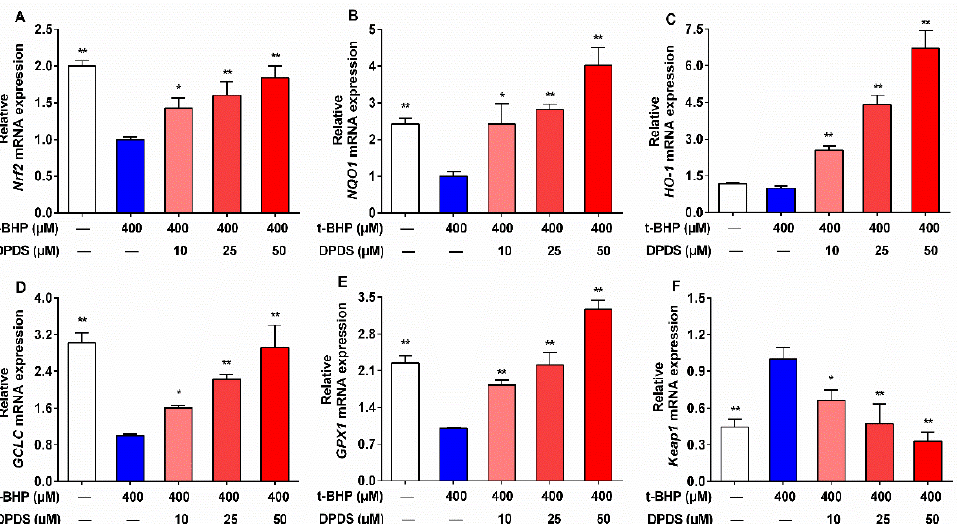
Figure 4. DPDS enhanced the gene expression of Nrf2 and antioxidant enzymes in t-BHP-stimulated HBZY-1 cells. HBZY-1 cells were incubated with t-BHP (400 μ M) alone or in combination with indicated concentrations of DPDS for 24 h. The relative mRNA levels of Nrf2 ( A ), NQO1 ( B ), HO-1 ( C ), GCLC ( D ), GPX1 ( E ) and Keap1 ( F ) expressed as fold of the t-BHP group. Gene levels were normalized against those of β -actin. Values are presented as means ± SEM, n = 3–4. * p < 0.05, ** p < 0.01 versus the 400 μ M t-BHP group.